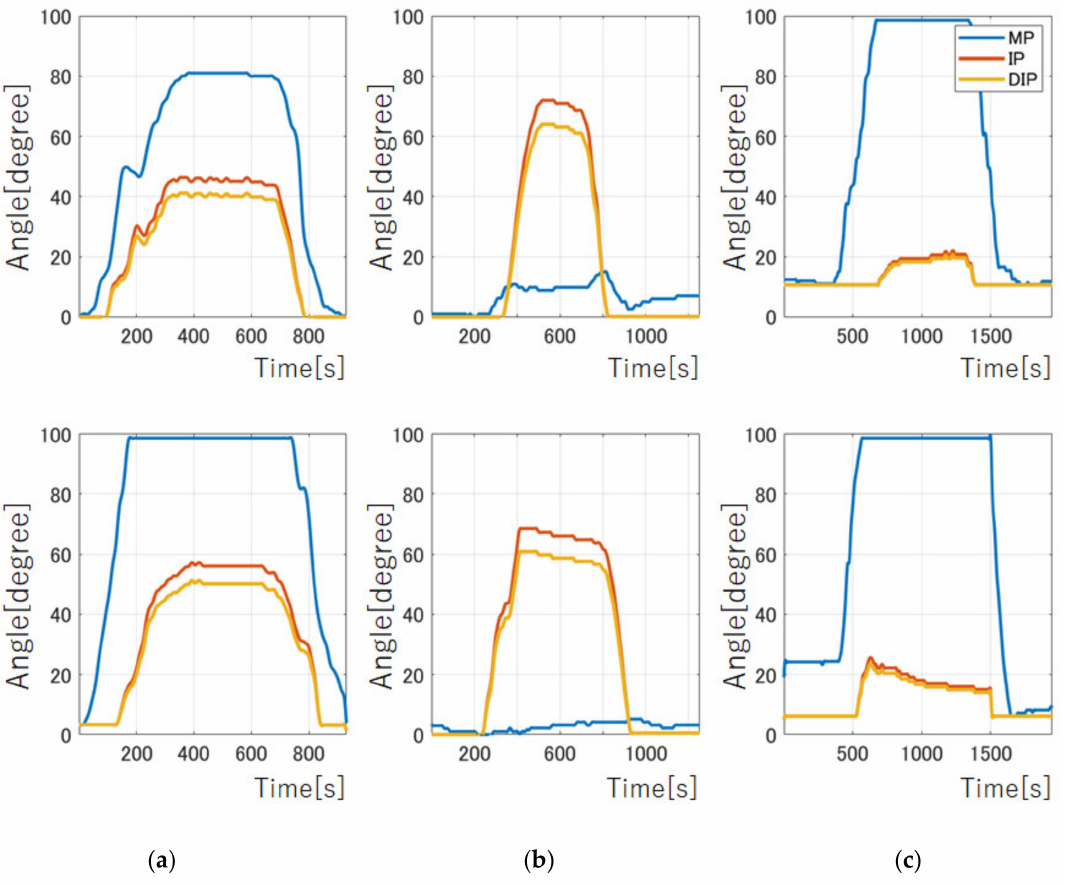
Figure 9. Angle of each joint from liquid metal sensor. Upper panel from human movements. Bottom panel from finger robot. Blue lines show MP joint movements. Red lines represent those of IP joint. Orange lines stand for those of DIP joint. ( a ) Flexion and extension operation; ( b ) IP/DIP joint operation; ( c ) MP joint only